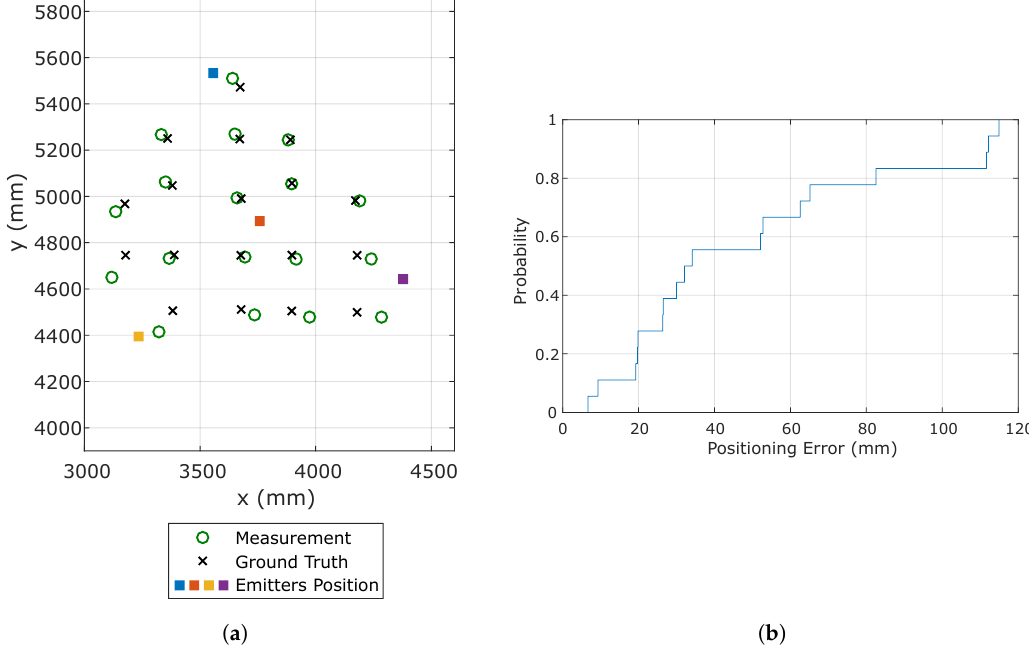
Figure 11. Positioning results using the information from the four emitters with CamPoseCalib(CPC). ( a ) Calculation of the receiver positions; ( b ) CDF of the positioning error.